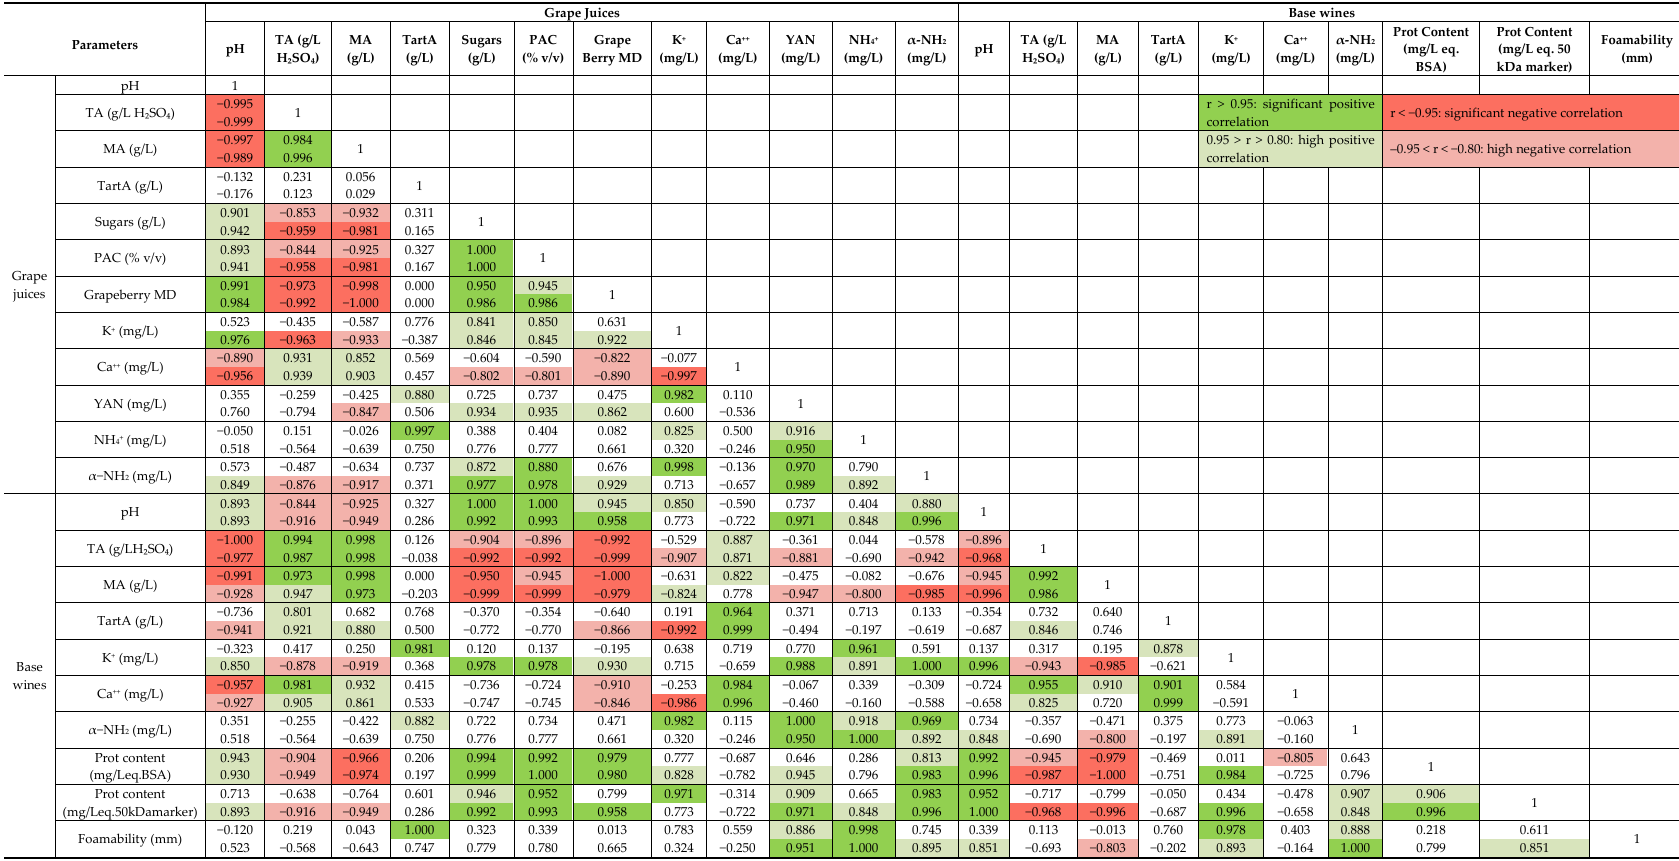
The correlation coefficients represent PM S1 (above) and PM S2 (below) in each grid. PM: Pinot meunier. S1 and S2: squeeze 1 and squeeze Table 4. Pearson test correlation coefficients ( r ) among the oenological parameters of Chardonnay grape juices and base wines ( p < 0.05).